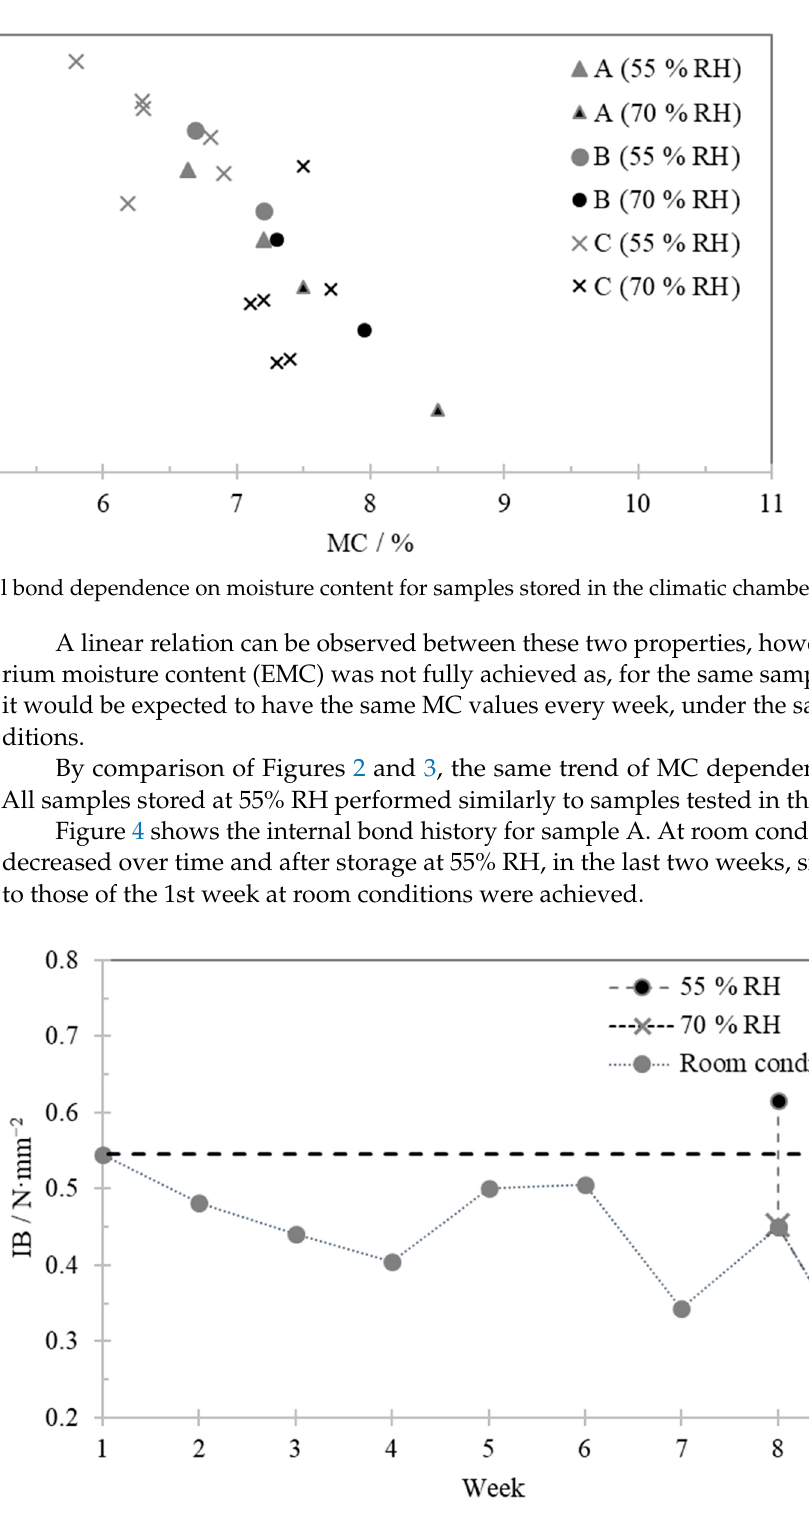
Figure 4. Internal bond history for sample A during the 9 week test period.